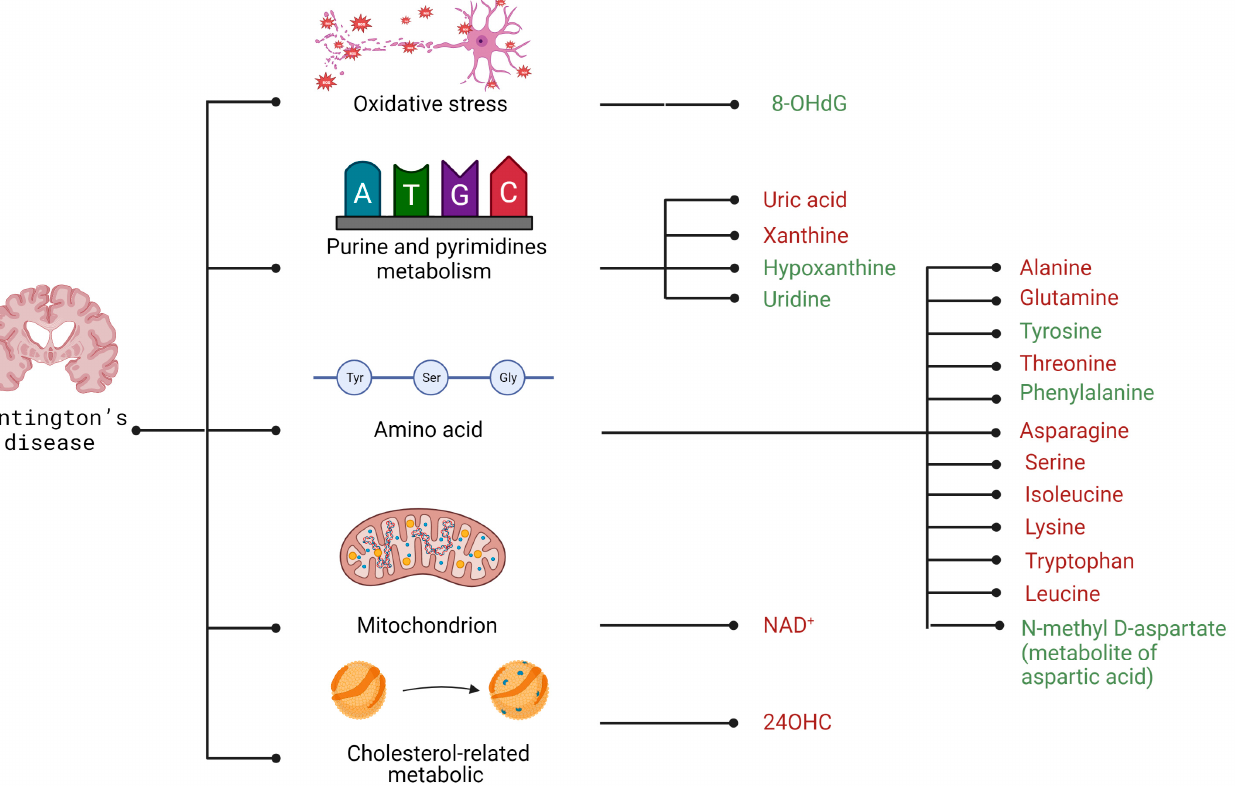
Figure 4. Biomarkers of HD related to energy metabolism disruption (green—increased levels, red—decreased levels).